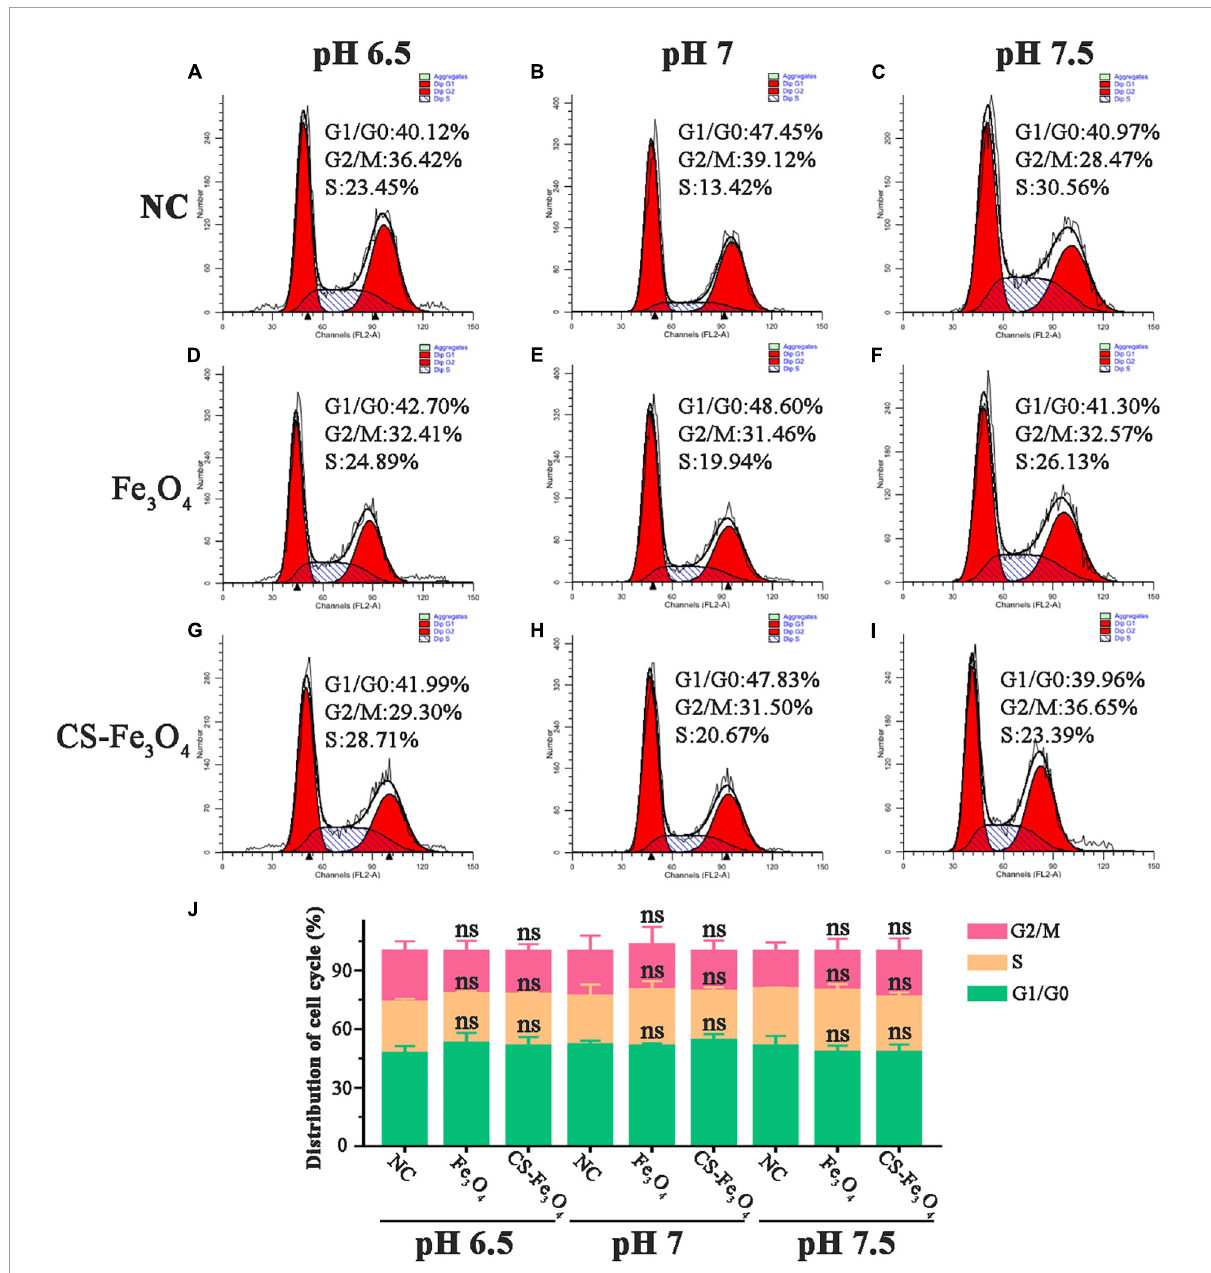
FIGURE7 Cell flow cytometry analysis of SKOV-3 cells (A–C) NC, (D–F) Fe 3 O 4 nanoparticles, and (G–I) CS-Fe 3 O 4 nanoparticles at different pH values 24 h after treatment. (J) The cell cycle distributions were analyzed in the histogram. ns: no statistical